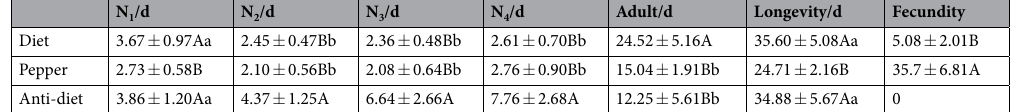
Table 1. Effects of artificial diets and antibiotic treatment on the development and fecundity of M. persicae (F 1 ). Data are mean ± SE. Different lowercase and uppercase letters within the same column indicate significant difference at 5% and 1% levels by using LSD multiple comparison method. Diet: Artificial diet; Anti-diet: Diet containing antibiotics.